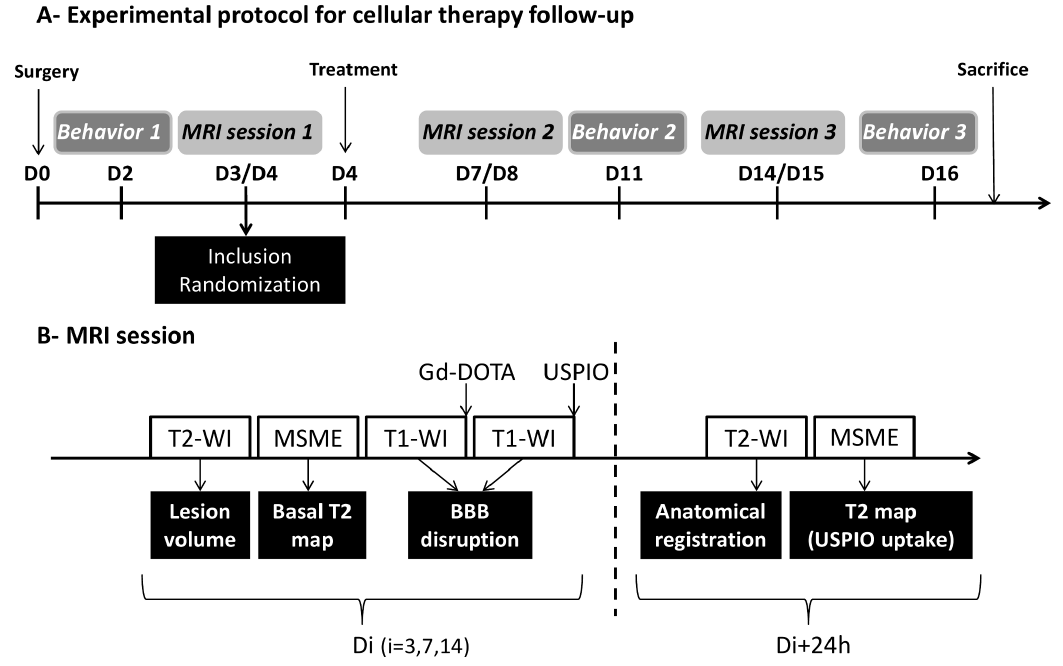
Figure 1. Experimental protocol and diagram of MRI session. ( A ) Experimental protocol. Surgery consisted in either transient middle cerebral artery occlusion (tMCAO) or sham operation. Treatment consisted in intravenous injection of either 2 million M2 macrophages diluted in 1 ml phosphate-buffered saline (PBS) or the same volume of pure PBS. The number of animals included is given in Table 1. ( B ) Diagram of one MRI session. T1/T2-WI: T1/T2-weighted imaging; MSME: Multi-Slice Multi-Echo; USPIO: ultrasmall superparamagnetic particles of iron oxide. BBB: blood-brain barrier. The sequence parameters are given in Table 3.